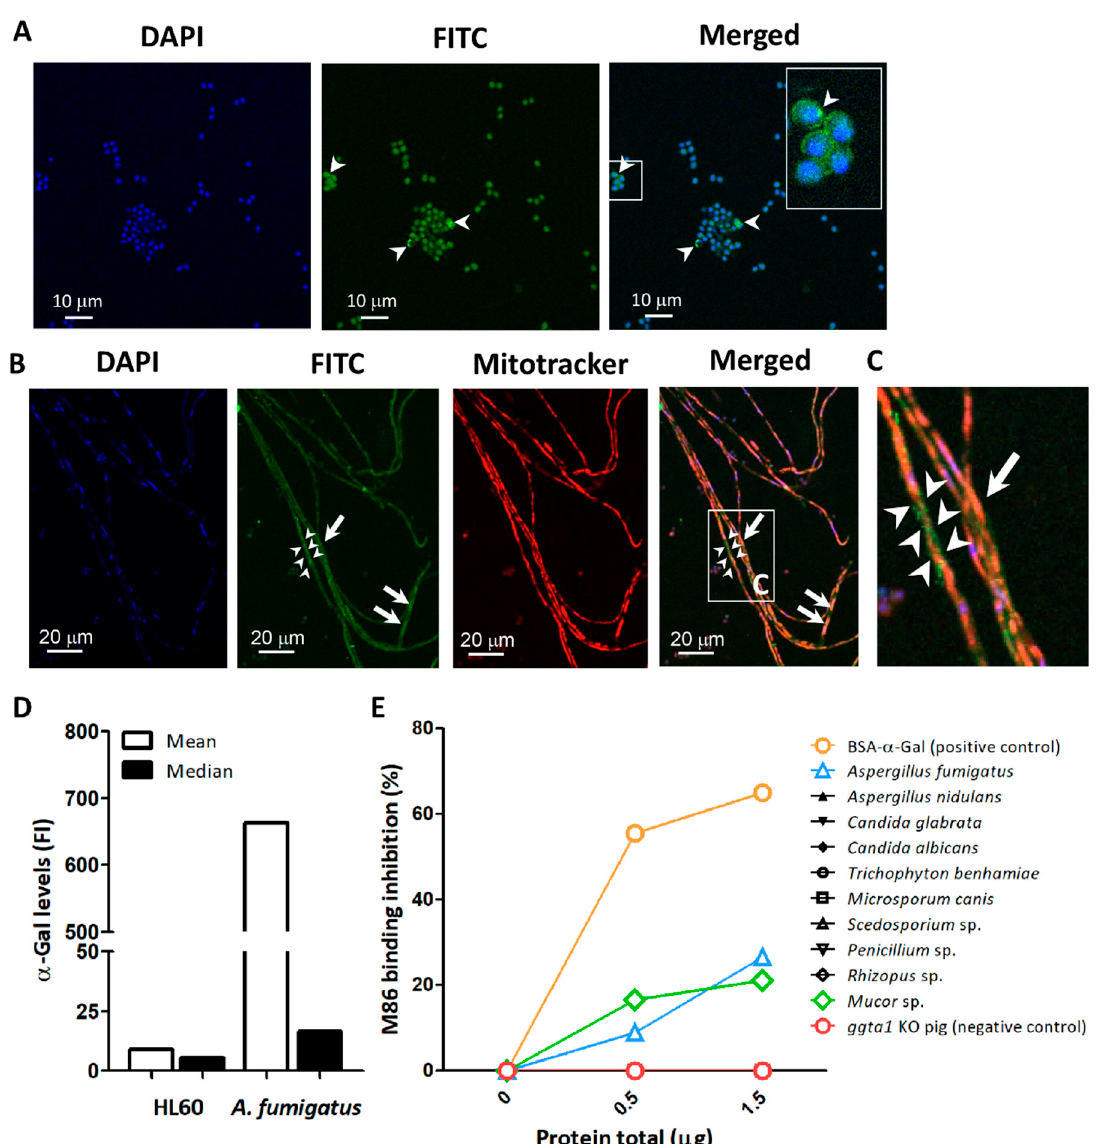
Figure 1. Detection of α -Gal in A. fumigatus . The α -Gal-specific mAb M86 (primary Ab) was used to detect the production of α -Gal in A. fumigatus conidia (arrow heads) ( A ) and hyphae ( B ) by immunofluorescence. The mAb M86 was reactive to granular structures surrounding the hyphae (arrow heads) and the cytoplasm of hyphae cells (arrows) ( B , C ). Goat anti-mouse IgM-FITC was used as secondary Ab for detection of α -Gal (green). Cell nuclei and mitochondria were stained with DAPI (blue) ( A , B ) and Mitotracker (red) ( B ), respectively. α -Gal expression in conidia surface was measured by flow cytometry using M86 and Goat anti-mouse IgM-FITC. Mean and median fluorescence intensity (FI) values are presented. HL60 cells were used as a negative control ( D ). Presence of α -Gal glycan in protein extract of Ascomycota (i.e., A. fumigatus , A. nidulans , C. glabrata , C. albicans , M. canis , Penicillium sp., Scedosporium sp., and T. benhamiae ) and Zygomycota (i.e., Mucor sp. and Rhizopus sp.) fungi was measured by inhibition ELISA assay ( E ).